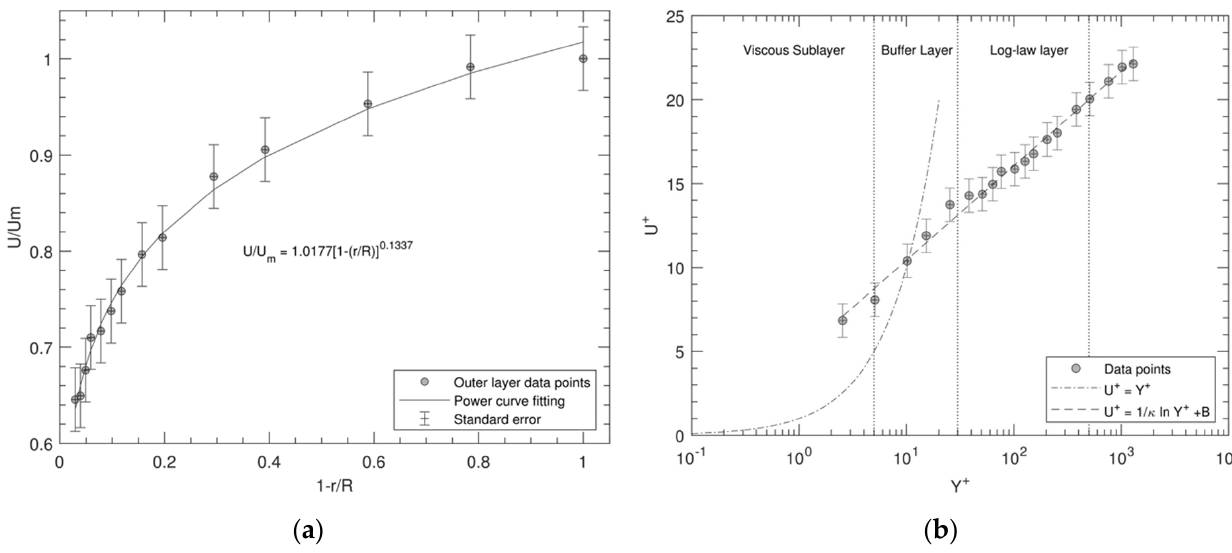
Figure 2. ( a ) Approximation of the normalized velocity fitted with the power-law curve; ( b ) Dimen- sionless velocity profile showing the regions of the turbulent boundary layer.